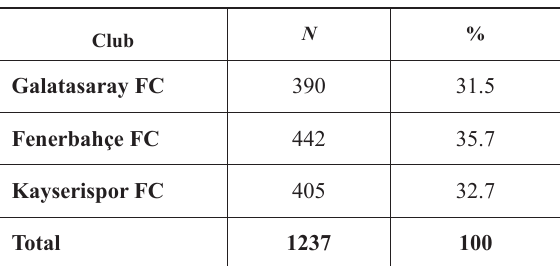
Table 2. Distribution according to football club fans groups